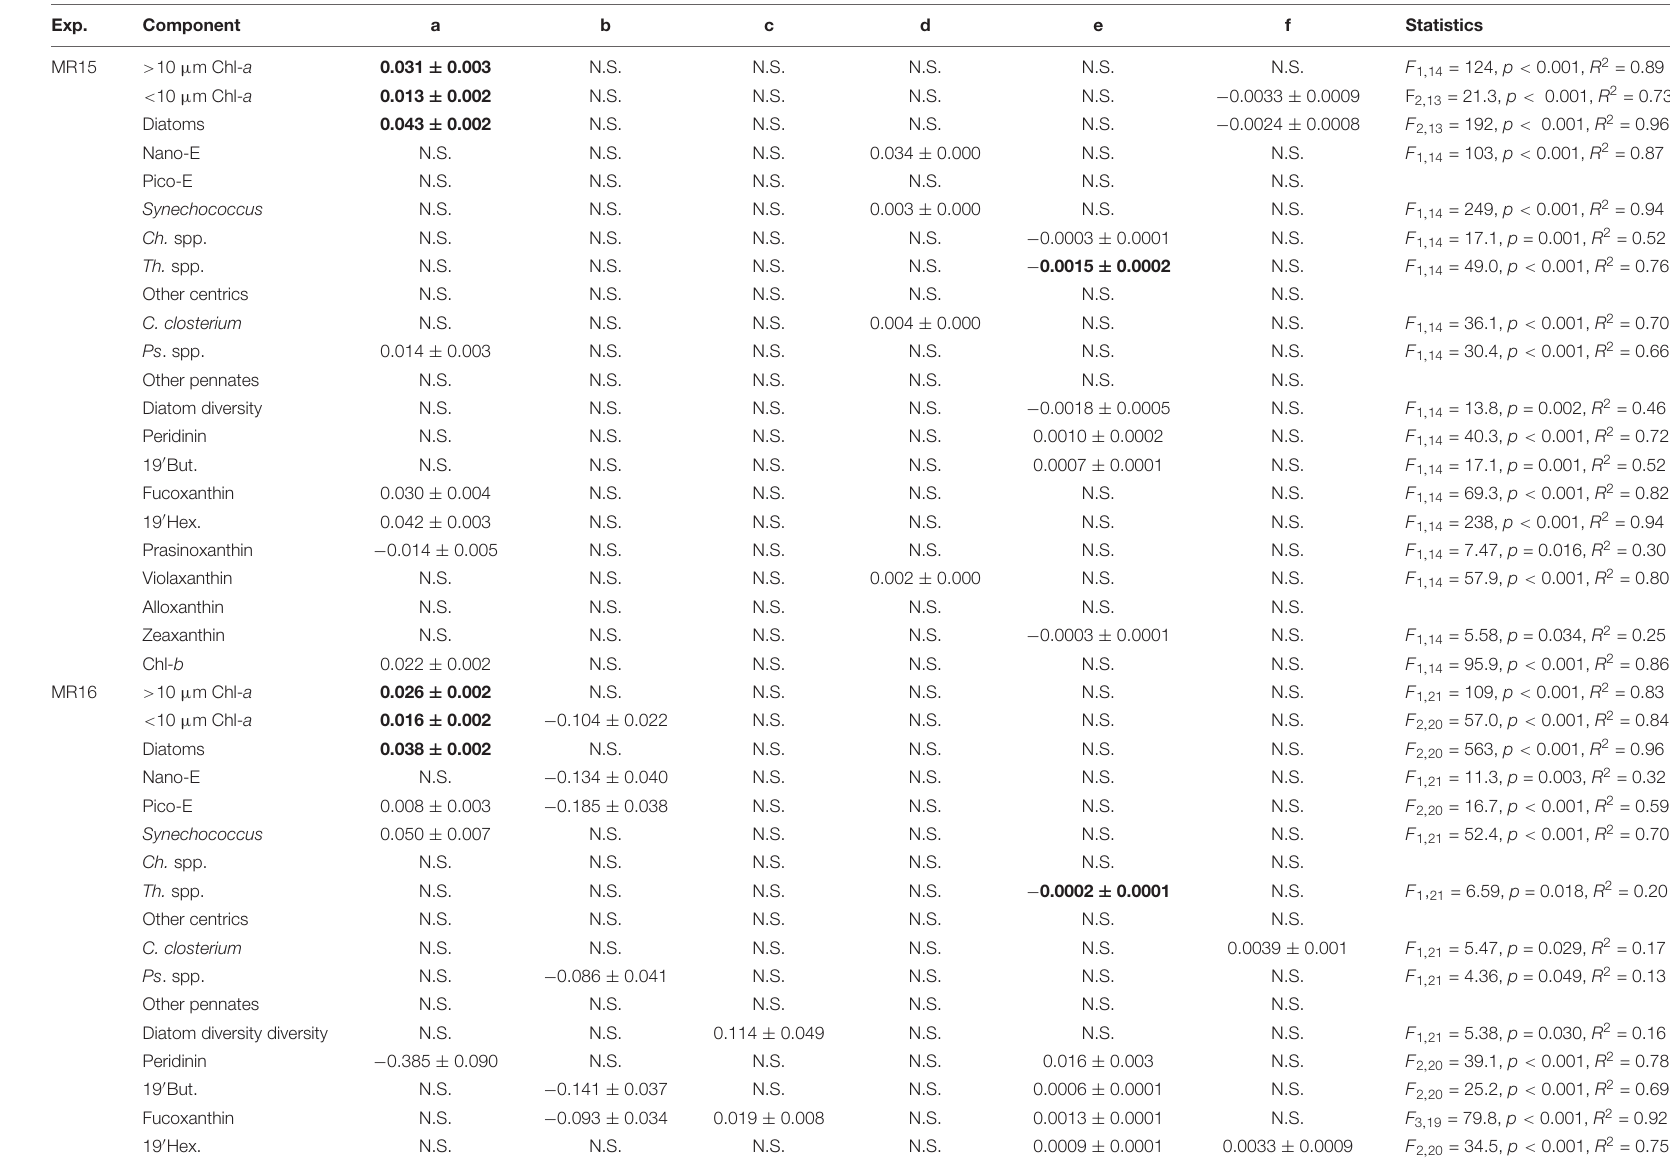
TABLE 2 | Statistical results of multiple regression analysis between environmental variables (Temperature: T, pH, and Salinity: S ) and the growth rate ( µ ) of phytoplankton and pigments. Listed are the coefficients of regression equation of µ = (a × T ) + (b × pH ) + (c × S ) + (d × T × pH ) + (e × T × S ) + (f × pH × S ). Consistent trends between two culture experiments represented in bold. Exp. Component a b c d e f Statistics MR15 > 10 µ m Chl- a 0.031 ± 0.003